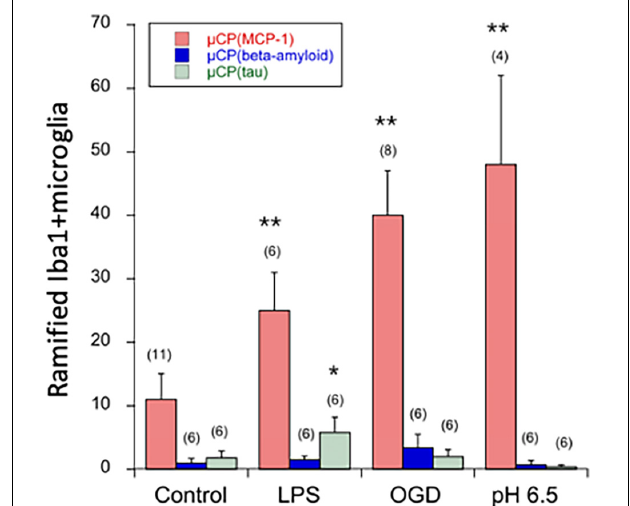
FIGURE 6 | Quantification of ramified Iba1+ microglia in the microcontact printing ( µ CP) assay loaded with MCP-1 (red bars), beta-amyloid (blue bars), or tau (green bars). Brain slices were prepared, cultured for 4 days in normal slice medium and then treated for 3 days without (minus, control), or with lipopolysaccharide (LPS) or oxygen-glucose deprivation (OGD) or acidosis (pH = 6.5), and then incubated for further 2 weeks in normal slice medium. Slices were then analyzed for microglial Iba1 by immunostainings, and quantified on a length of 300 µ m on both sides of the two slices and the values of four measurements averaged. For better graphical illustration of the data, the migration distance was multiplied by a factor of 10. The number of analyzed mice is given in parenthesis. Values are given as mean ± SEM cells per 300 µ m. Statistical analysis was performed by ANOVA with a Fisher’s LSD post hoc test vs. the control group (* p ≤ 0.05; ** p ≤